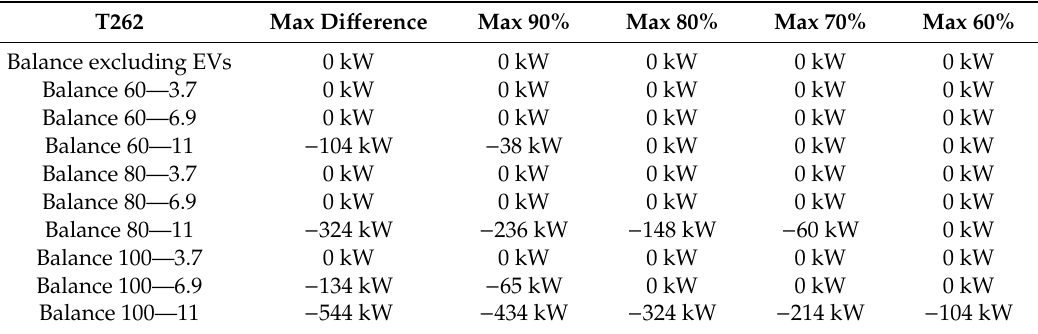
Table 11. Replacement of electric heating by district heating for transformer T262—constant